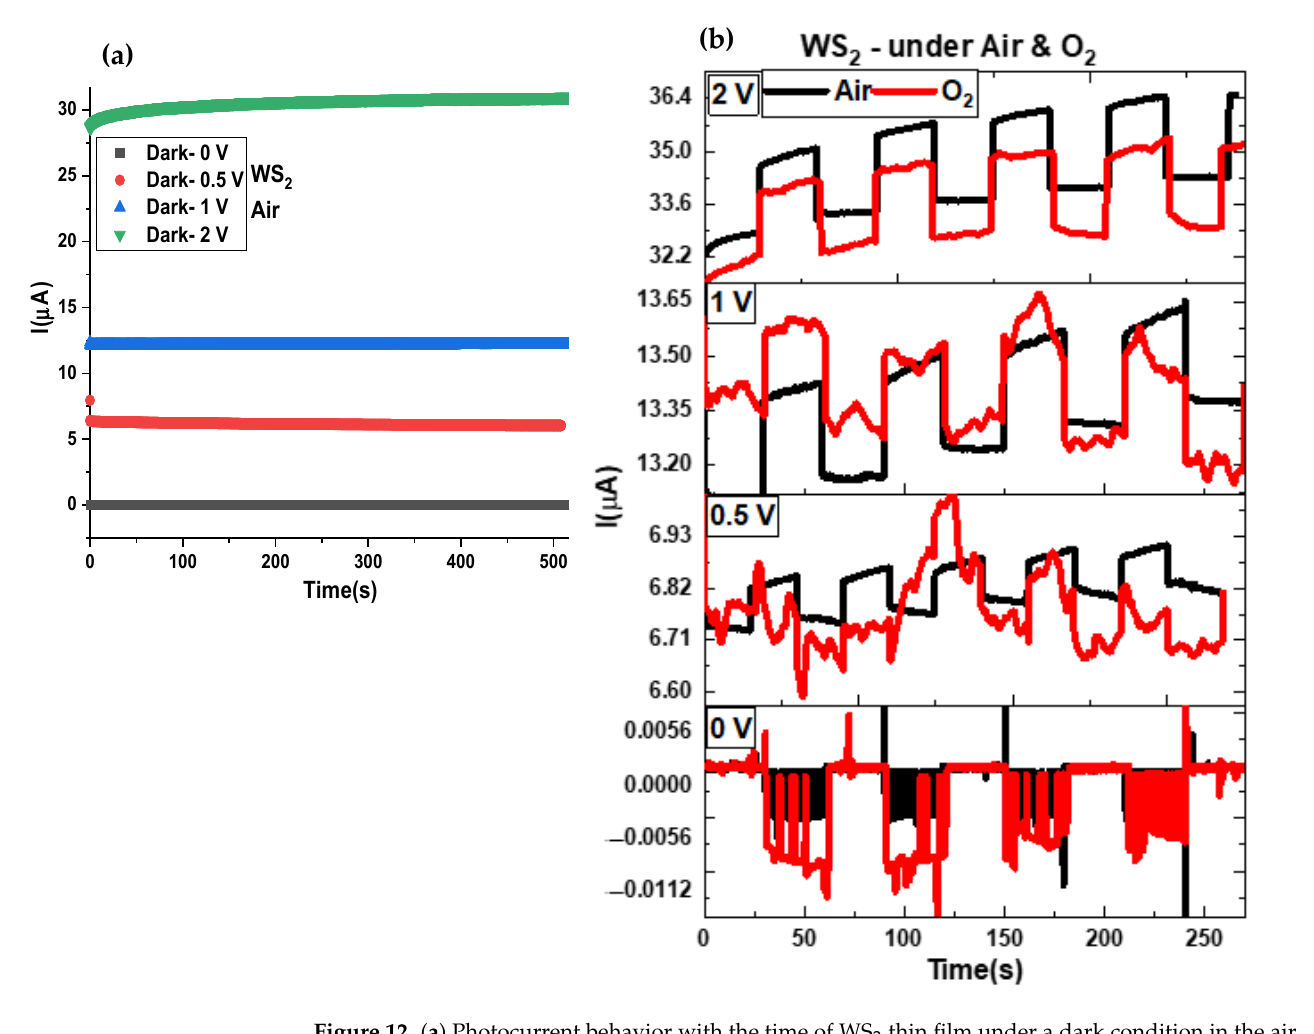
Figure 12. ( a ) Photocurrent behavior with the time of WS 2 thin film under a dark condition in the air at a different bias voltage of 0, 0.5, 1, and 2 V. ( b ) The on–off dynamics of the current with a time of WS 2 thin film in air and 50 sccm O 2 environments under a different bias voltage of 0–2 V. By these means, we measured the photocurrent of WS 2 at 2 V under air and CO 2 . Figure 13a show the photocurrent behavior with a time of WS 2 thin film under dark and UV conditions in CO 2 at a bias voltage of 2 V. We see that the general behavior is positive photoresponse. The demonstrated results show that WS 2 film presented long-term stability in CO 2 and also in the air with time. Figure 13b shows the on–off photoresponse dynamics of WS 2 thin film in air, 50 sccm O 2 , and 50 sccm CO 2 environments under a bias voltage of 2 V. The photocurrent of WS 2 thin film is largely enhanced by introducing CO 2 gas under UV illumination. In contrast, for the air and O 2 environment, we do not see a large enhancement in the photocurrent. The on–off curve shows high stability during many pulses. Under the same conditions, the WS 2 introduced a higher sensitivity to environmental gases including CO 2 and O 2 than MoS 2 thin film. In addition, we found that the high photocurrent is shown under the CO 2 stimuli for WS 2 under various gas conditions.